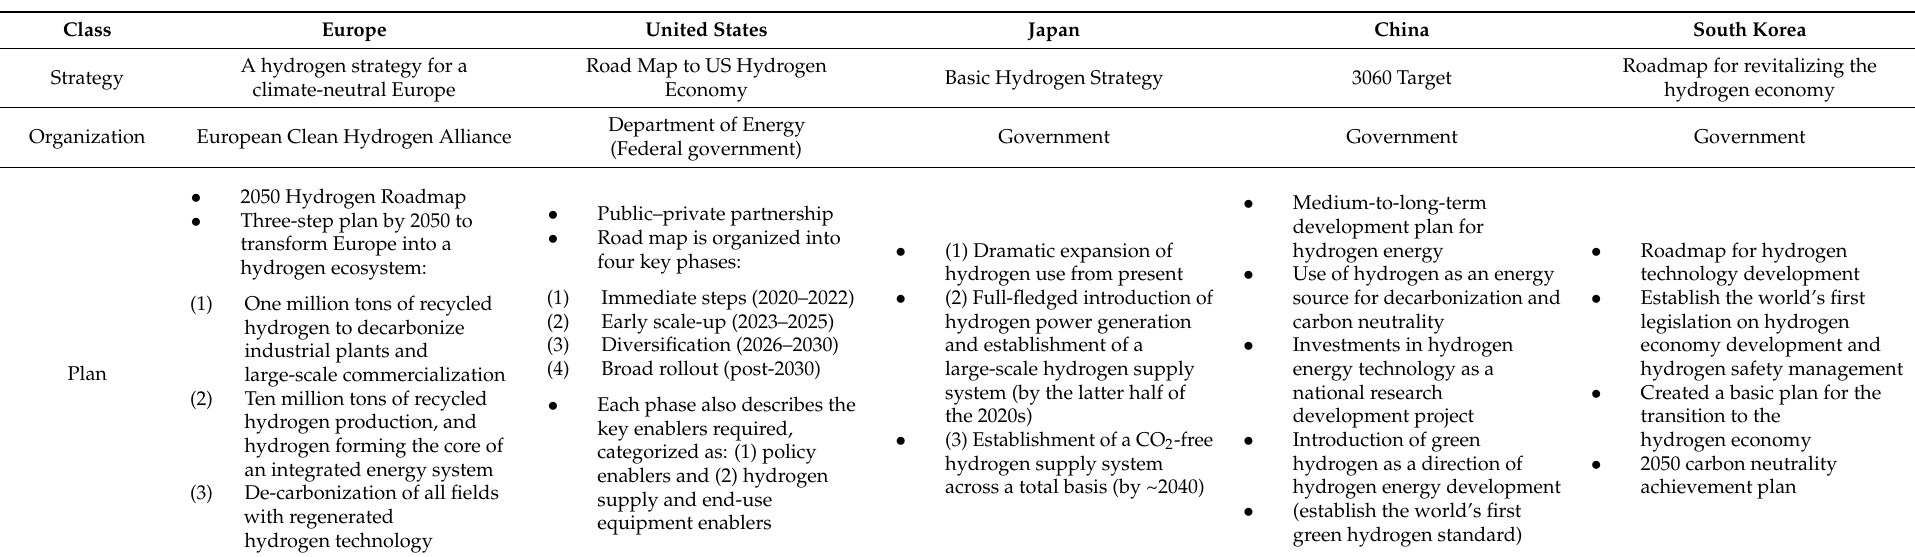
Table 1. Hydrogen policy strategies and plans for key